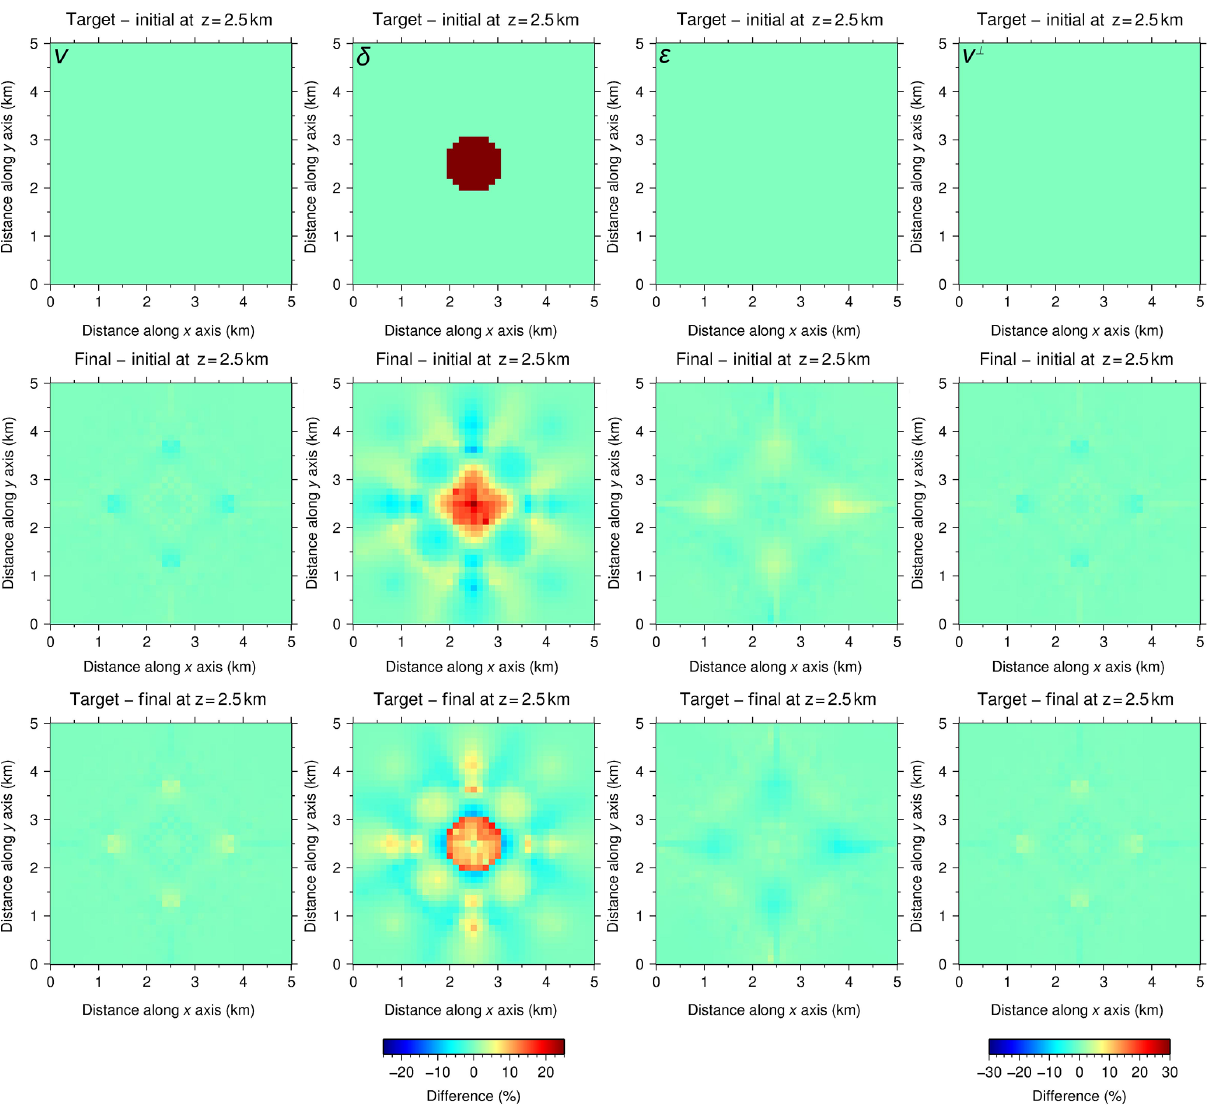
Figure 9. Same as Fig. 5 but using target models as initial models for all parameters in P[ ε ] but δ . This test was conducted to study the recovery of δ under unrealistically optimal circumstances, and even with these perfect initial conditions, recovery is, at best, extremely complicated due to the small sensitivity (Fig. 2); magnitude and shape are only partially recovered. In the first row, differences for v and ε are 0% since we use target models as initial ones. For this same reason, the second and third rows show that differences between target and inversion for these three parameters are hardly observable, indicating that inversion is not modifying v and ε even though they are not fixed. Consequently, the resulting recovery of v ⊥ through Eq. (2) is almost perfect as